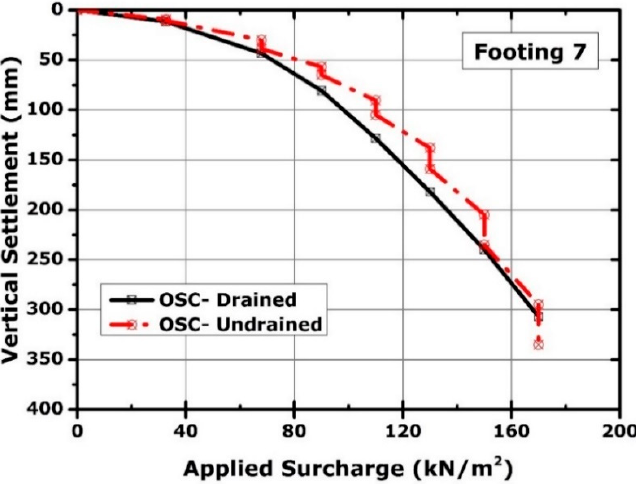
Figure 15. Load-displacement response for Footing 7.